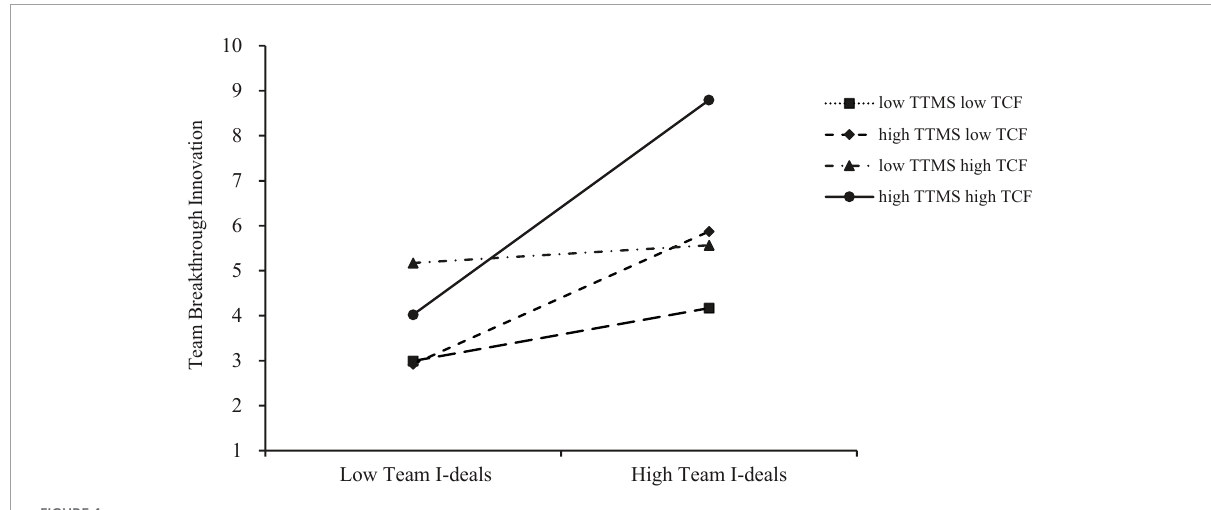
FIGURE4 Two-stage combined moderating effect. This figure shows the moderated mediating effect under four combinations of TTMS and TCF at different